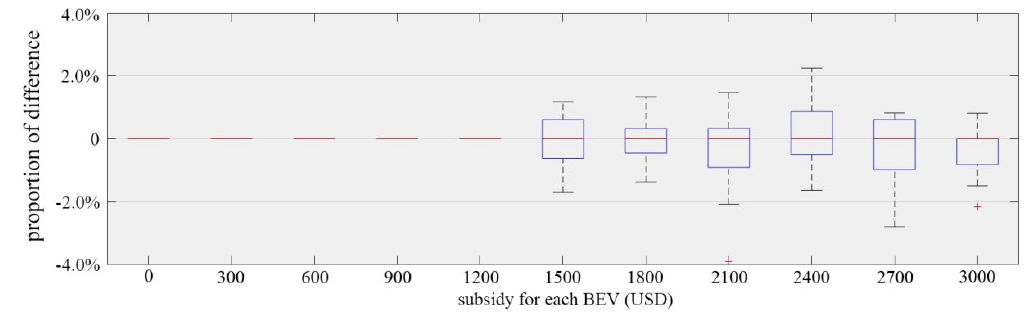
Figure 7. The boxplot of running the local search 20 times.